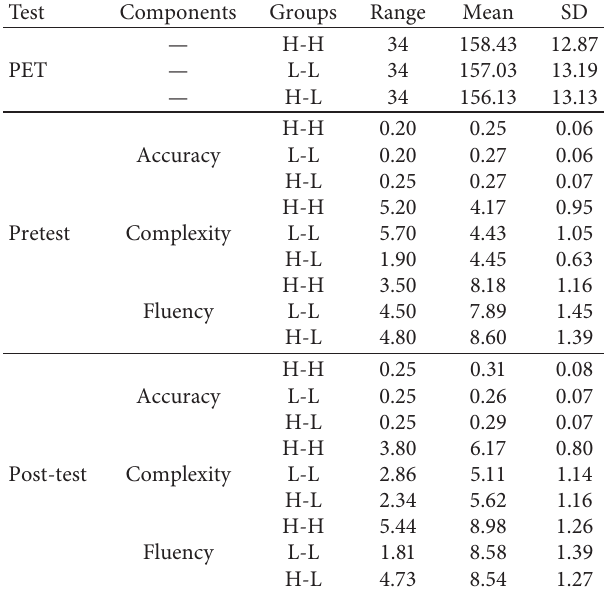
Table 2: Results of the Kruskal–Wallis H test for the PET and pretest among the three groups.